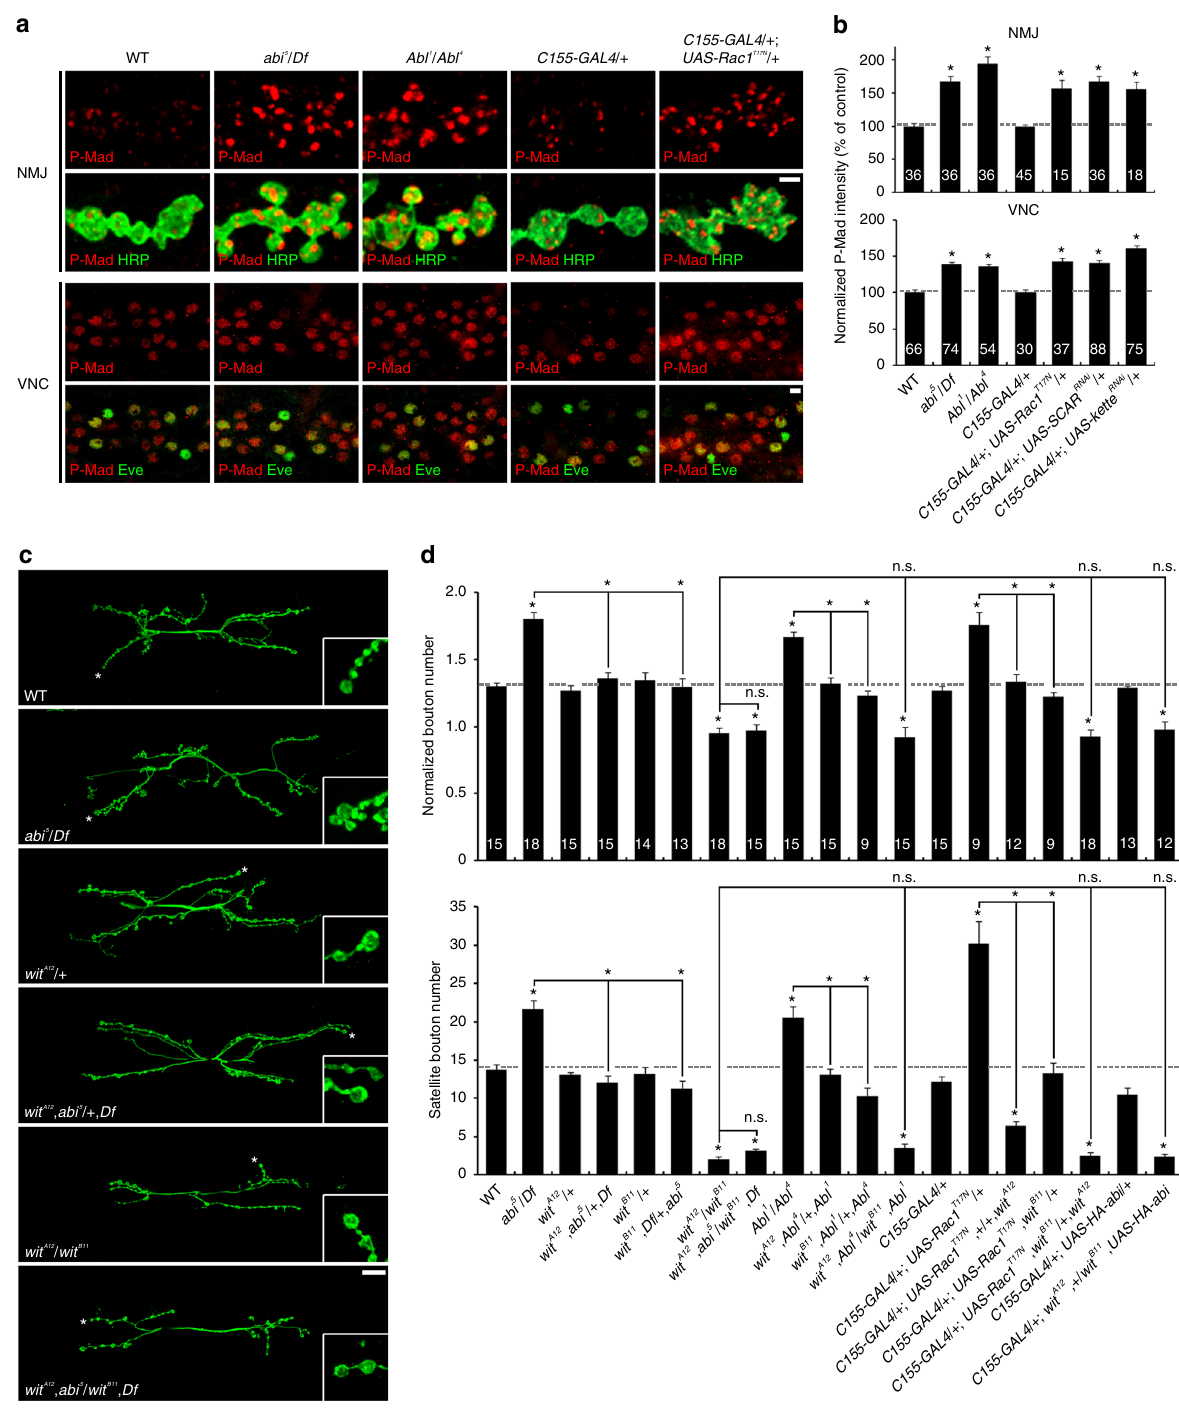
Fig. 4 Abi pathway restrains synaptic development by inhibiting bone morphogenetic protein (BMP) signaling. a , b Loss of Abi, Abl, and Rac1-SCAR components increases P-Mad in motor neurons. a Single confocal sections of neuromuscular junction (NMJ) 6/7 (top) and ventral nerve cord (VNC) co- labeled with anti-P-Mad and anti-HRP (NMJ) or anti-Even Skipped (Eve; VNC) shown for wild type, abi 5 / Df , Abl 1 / Abl 4 , C155 - GAL4 / + , and C155 - GAL4 / + ; UAS - Rac1 T17N / + . b Quanti fi cation of P-Mad intensity normalized to HRP or Eve in the indicated genotypes. c , d Synaptic overgrowth induced by loss of Abi, Abl, or presynaptic Rac1 depends on BMP signaling. c Sample confocal images of anti-HRP-labeled NMJs in wild type, abi 5 / Df , wit A12 / + , wit A12 , abi 5 / + , Df , wit A12 / wit B11 , and wit A12 , abi 5 / wit B11 , Df . d Quanti fi cation of synaptic structure at NMJ 6/7 in the indicated genotypes. Bar graphs indicate mean ± s.e.m. The number of NMJ branches ( b , upper panel), Eve-positive motor neurons ( b , bottom panel), or NMJs ( d ) analyzed for each genotype is indicated inside bars. All comparisons are with wild type ( b , d ) unless indicated (one-way analysis of variance with Tukey – Kramer post hoc test; * P < 0.001; n.s. not signi fi cant). Scale bars: a , 2 μ m (NMJ); a , 5 μ m (VNC); c , 20 μ m